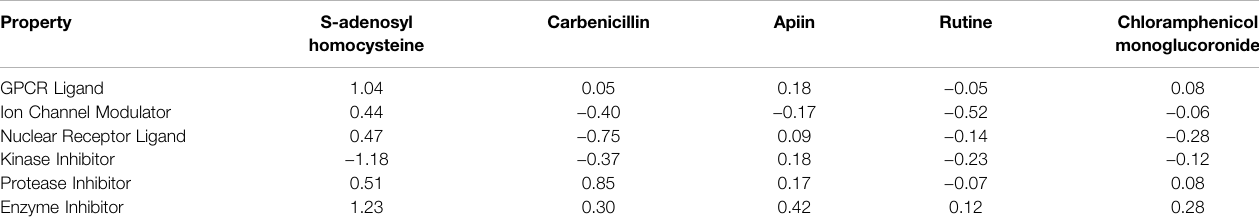
TABLE 2 | Bioactivity scores ofthe studied molecules calculated on the basis of the GPCR ligand, ion channel modulator, nuclear receptor ligand, kinase inhibitor, protease inhibitor, and enzyme inhibitor interactions. Property